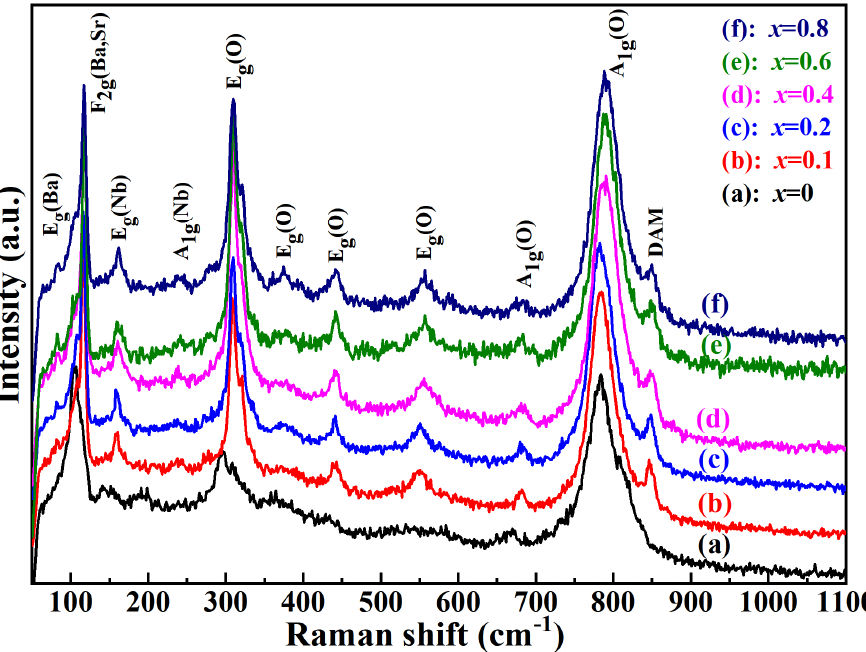
Figure 4. Raman spectra of Ba 1 − x Sr x (Zn 1/3 Nb 2/3 )O 3 ( x = 0–0.8) ceramics.